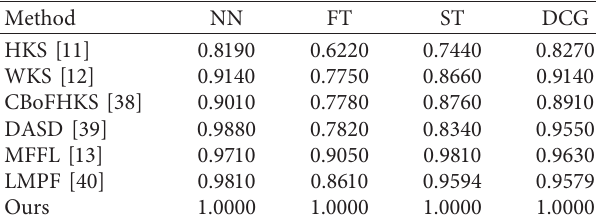
Table 7: Performance comparison on McGill.